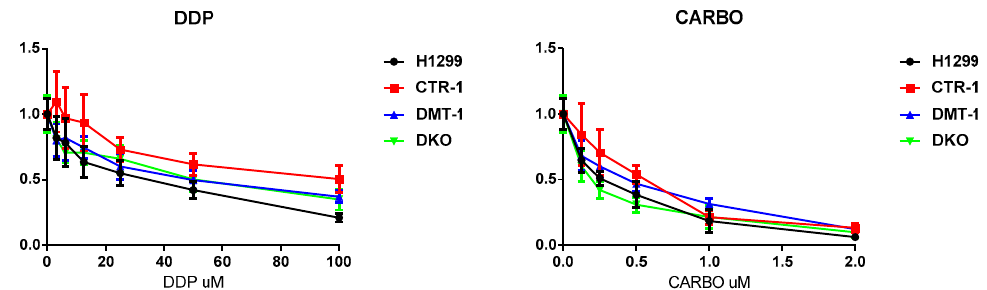
Figure 8. Cytotoxic activity of cisplatin and carboplatin in H1299 parental cells and in KO derived. X- axis: drug concentration. Y-axis: growth rate. Growth inhibitory activity was determined using the MTS test. Each point represents the mean ± SD of six replicates.